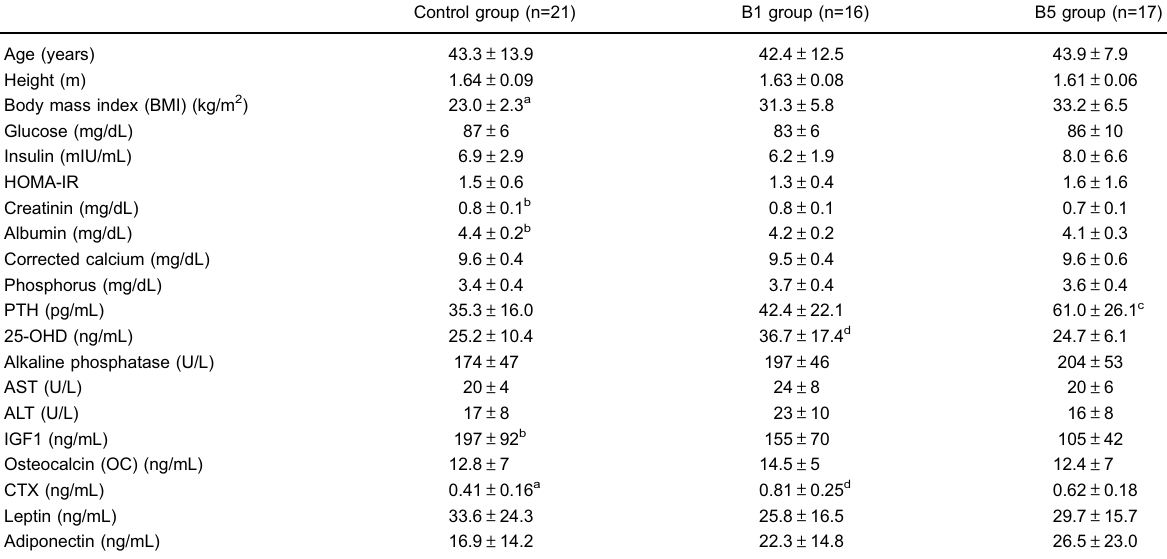
Table 1. Clinical characteristics of the control group, and obese women evaluated one year (B1) and fi ve (B5) years after Roux-en-Y gastric